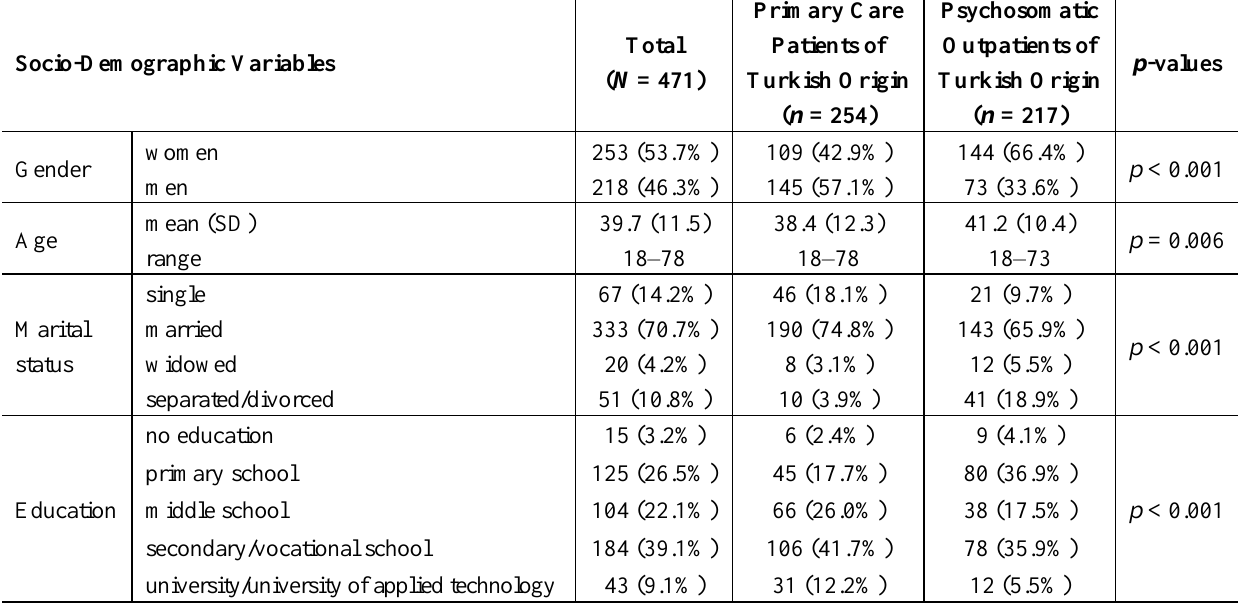
Table 1. Demographic characteristics of the study